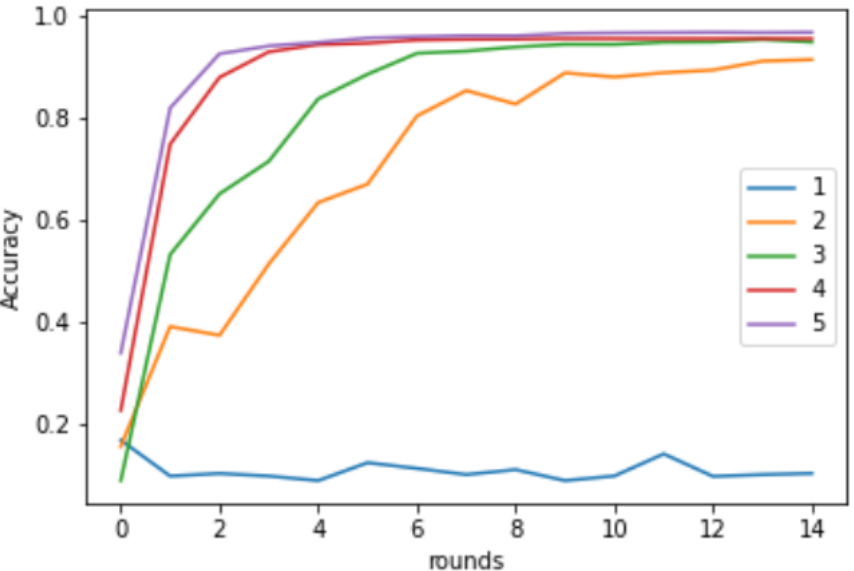
Figure 9. Performance of FedAvg with environement of clients having different number of categories using the MNIST dataset.